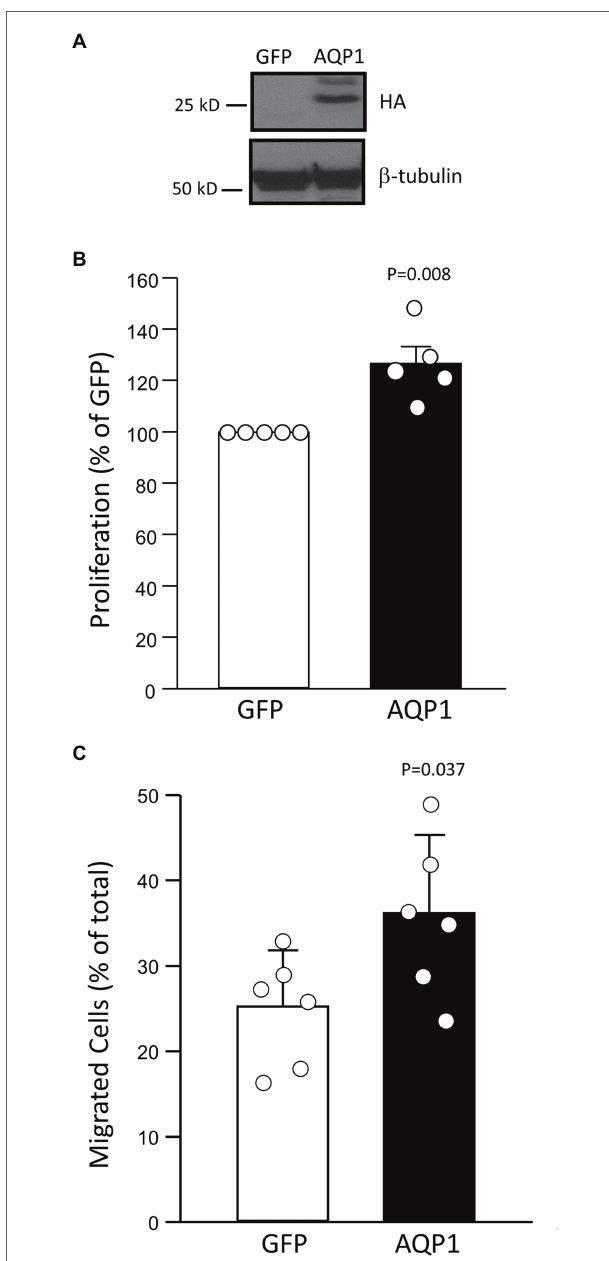
FIGURE 6 | Effect of increasing AQP1 on proliferation and migration. (A) Representative images demonstrate a level of HA-tagged AQP1 protein expressed following infection with an adenovirus containing GFP or AQP1 compared to β -tubulin (loading control). (B) Bar graph (mean ± SD values) for proliferation, measured by BrdU incorporation and normalized to control, in pulmonary MVECs isolated from control rats and infected with GFP- or AQP1- containing virus. Value of p determined from Mann Whitney Rank Sum Test. (C) Bar graph (mean ± SD values) for migrated cells in MVECs from control rats infected with virus-containing GFP or AQP1. Values of p determined by t -test. For all graphs, each dot represents samples from different